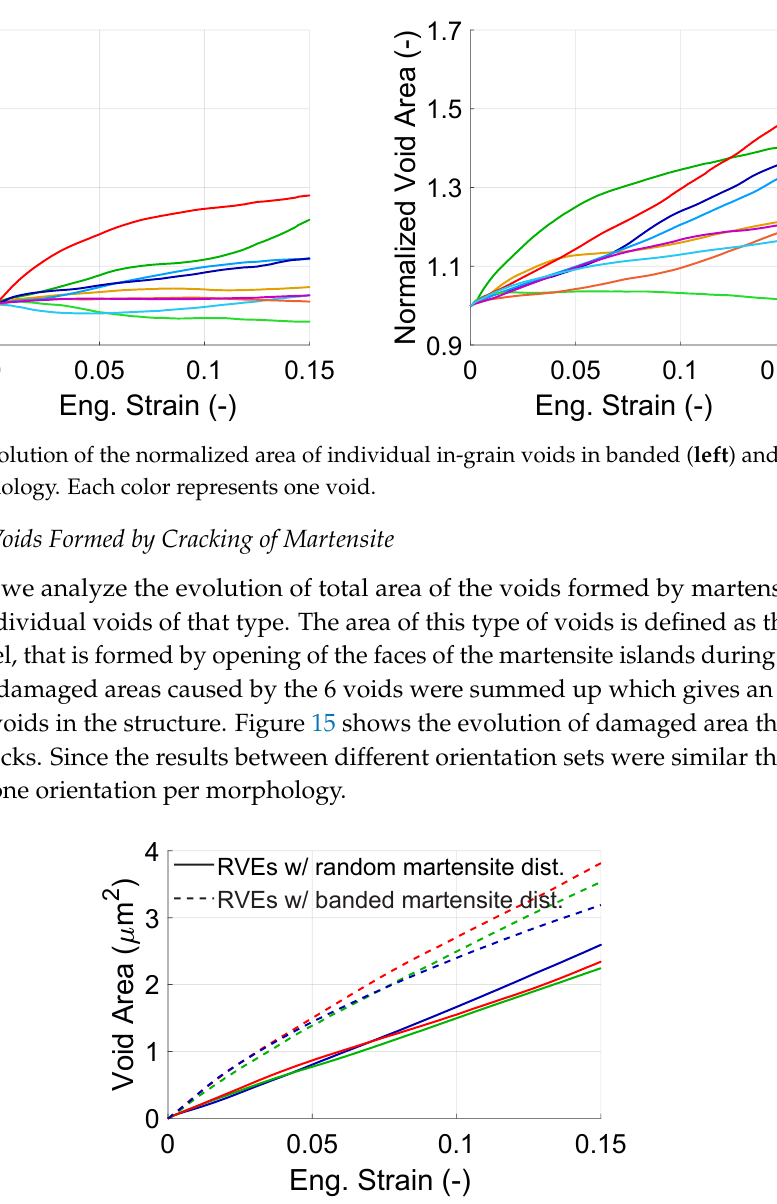
Figure 14. Evolution of total area of the voids formed by martensite cracks for 3 different orientation sets for random and banded distribution of martensite with total strain. Each color represents an orientation